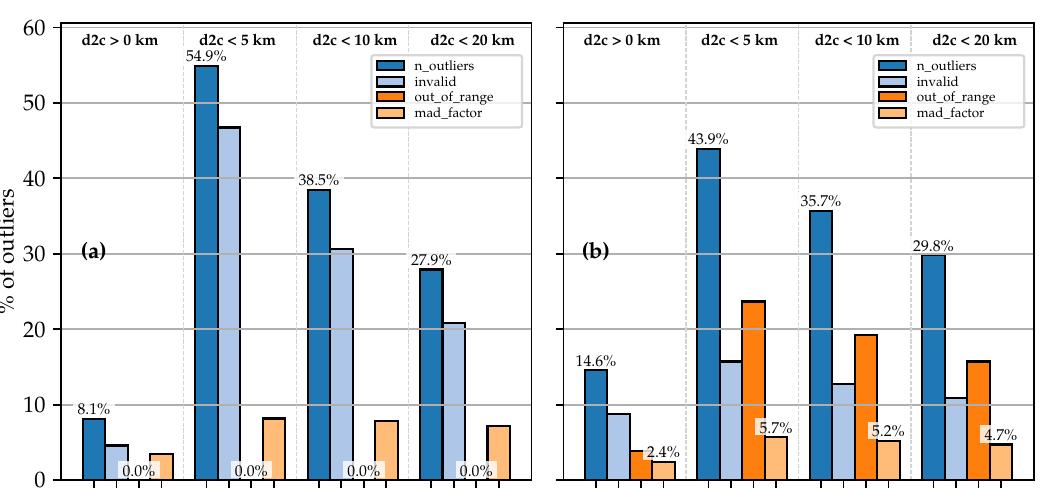
Figure 4. A comparison of outlier types as a function of dist2coast for the retrackers ( a ) Brown-Peaky and ( b ) TALES.